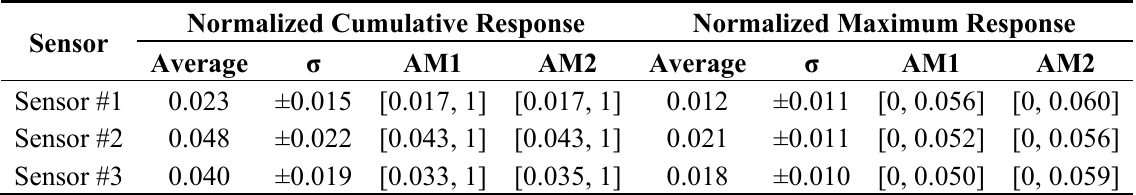
Table 1. Normalized cumulative and maximum responses selected for AM1 and AM2 Normalized Cumulative Response Normalized Maximum Response Sensor